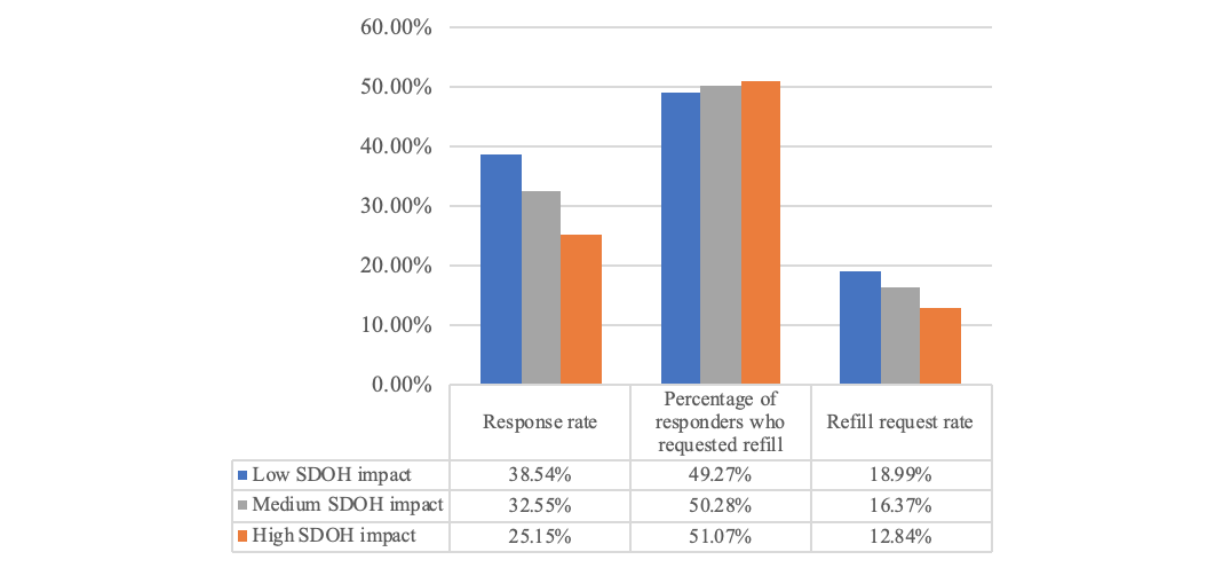
Figure 5. Social determinants of health impact on response rates and percentage of responders who request refill. SDOH: social determinants of health.